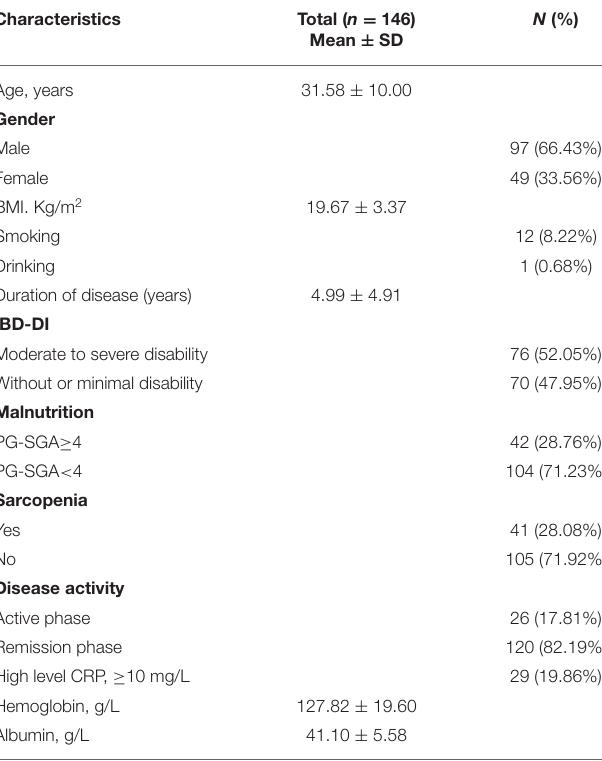
TABLE 1 | Characteristics of the study participants. TABLE 2 | Activity phase differences in the prevalence of sarcopenia and disability in CD